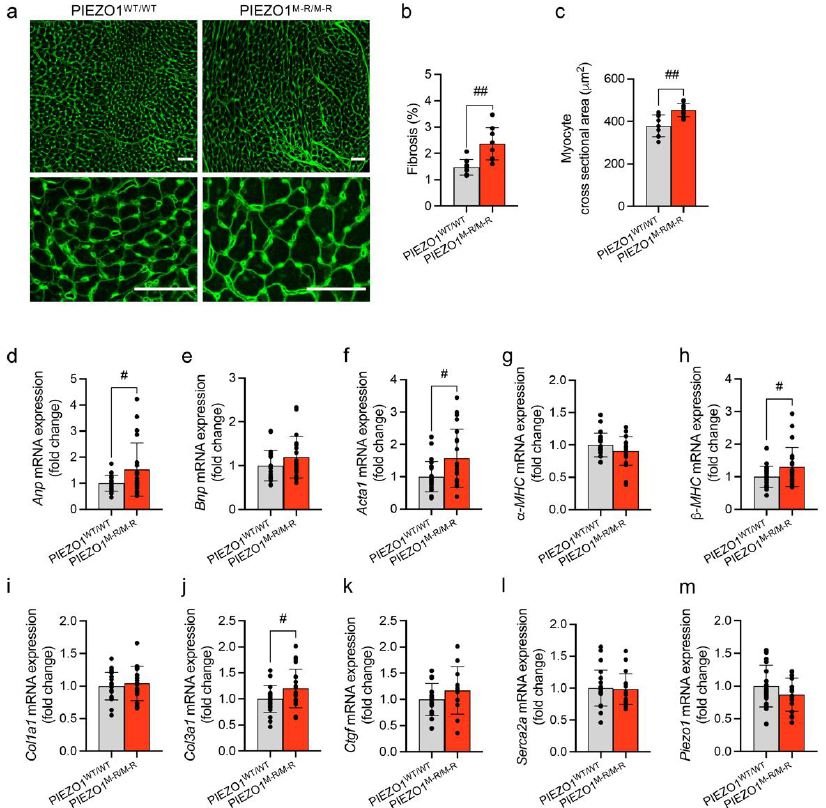
Figure 3. PIEZO1 gain-of-function mutation causes cardiomyocyte hypertrophy and myocardial fibrosis. ( a ) WGA (wheat germ agglutinin) stained heart cross-sections of the PIEZO1 WT/WT and PIEZO1 M-R/M-R mice. Scale bars = 50 μm. ( b ) Quantitative analysis of total fibrotic area and ( c ) cardiomyocyte cross-sectional area using images of the type shown in ( a ). ( d – m ) Quantitative PCR mRNA expression data for Anp , Bnp , Acta1 , α -MHC , β -MHC , Col1a1 , Col3a1 , Ctgf , Serca2a and Piezo1 genes in whole heart of PIEZO1 WT/WT and PIEZO1 M-R/M-R mice. mRNA levels were normalised to reference gene expression and presented as fold change relative to PIEZO1 WT/WT mice. Data are for n = 9 PIEZO1 WT/WT and 9 PIEZO1 M-R/M-R mice for ( a – c ); n = 21–23 PIEZO1 WT/WT and 18–21 PIEZO1 M-R/M-R mice for ( d – j , l , m ); n = 15 PIEZO1 WT/WT and 12 PIEZO1 M-R/M-R mice for ( k ) (mean ± S.D.). Superimposed dots represent the individual values for each animal. # p < 0.05; ## p < 0.01 vs. PIEZO1 WT/WT mice. Unpaired Student’s t -test was used to evaluate statistical